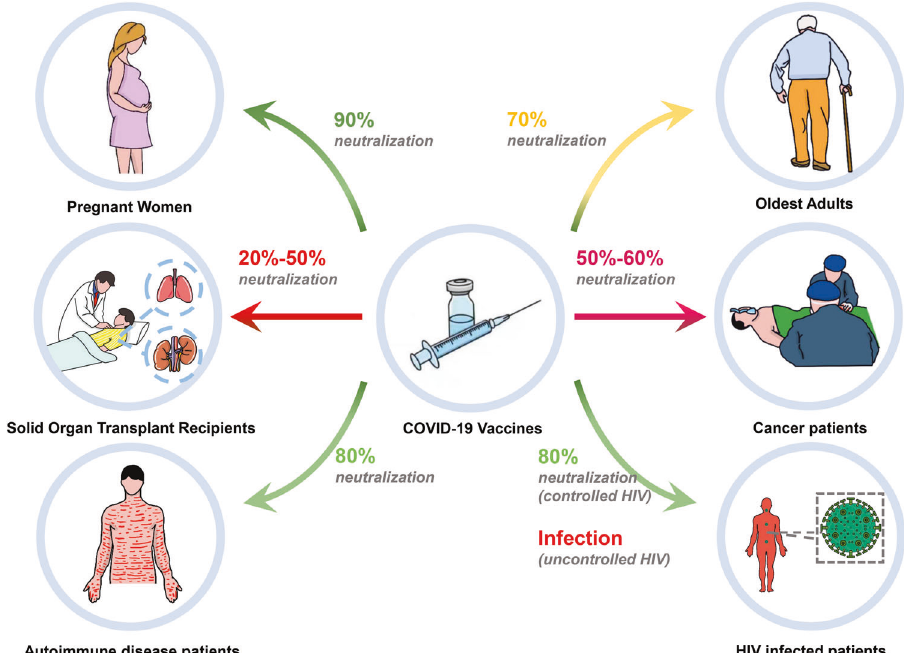
Fig. 9 Effect of vaccination in different populations. COVID-19 vaccines are still effective for pregnant women, patients with autoimmune diseases, and controlled HIV-infected patients, and the overall ef fi cacy can maintain about 80 – 90%, while the 30% neutralization reduction occurs in older people. Moreover, the overall neutralizing activity of COVID-19 vaccines in solid organ transplant recipients, cancer patients, and uncontrolled AIDS patients is signi fi cantly